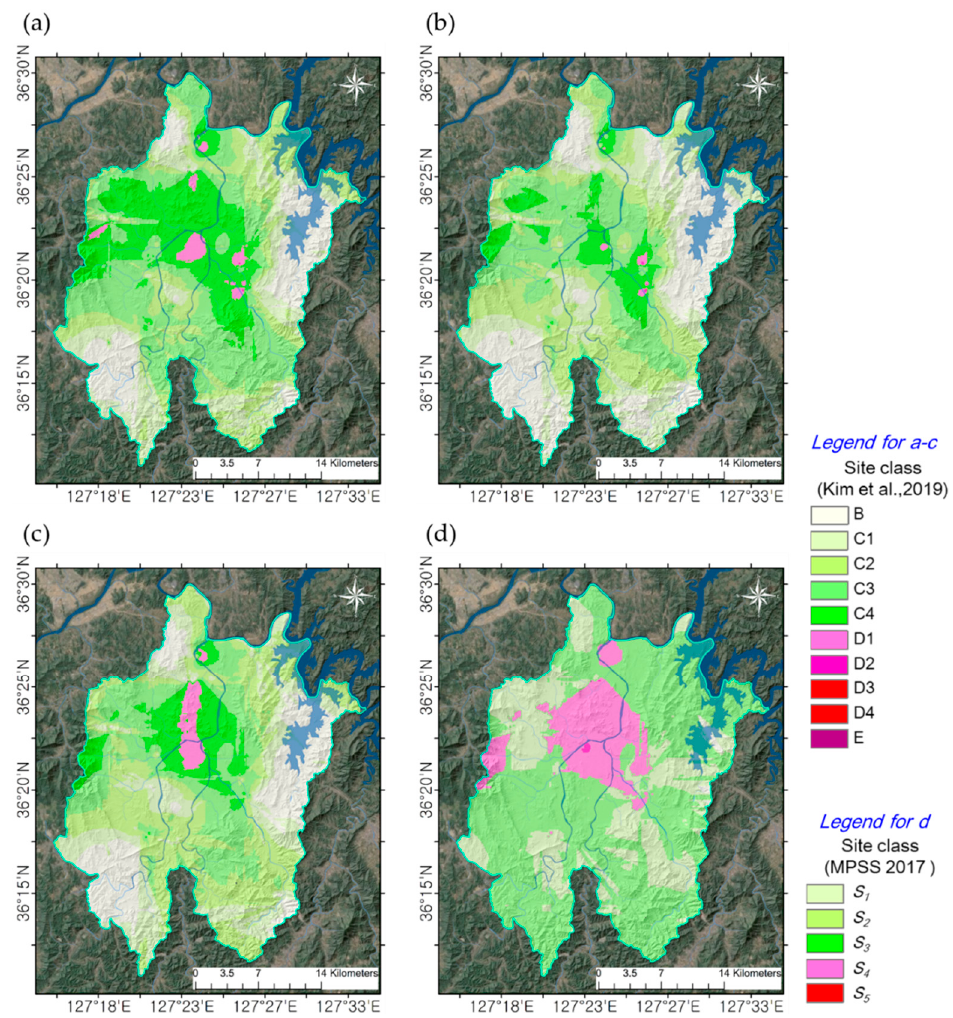
Figure 10. Regional site classification of the seismic site effect parameters: ( a ) V S 30 ; ( b ) T G ; ( c ) H ; and ( d ) the combination of V S,Soil and H based on MPSS 2017. V S 30 , T G , and H were categorized by Kim et al. [55].